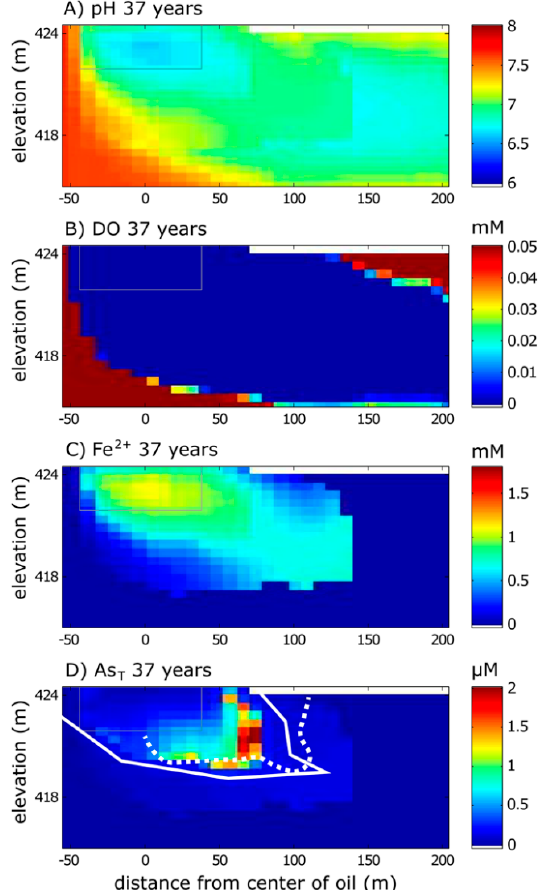
Figure 2. Model simulation results from the calibrated model for ( A ) pH, ( B ) DO, ( C ) dissolved Fe 2+ , and ( D ) total dissolved As (As T ) for 37 years after the oil spill (2016). The solid white line for dissolved As T represents the simulated 10 µg/L front. The dashed white line for As T represents the approximate extent of the 10 µg/L front based on field sampling (data available in [29]). The gray box is the reference for the oil body extent. Top boundary is the water table.